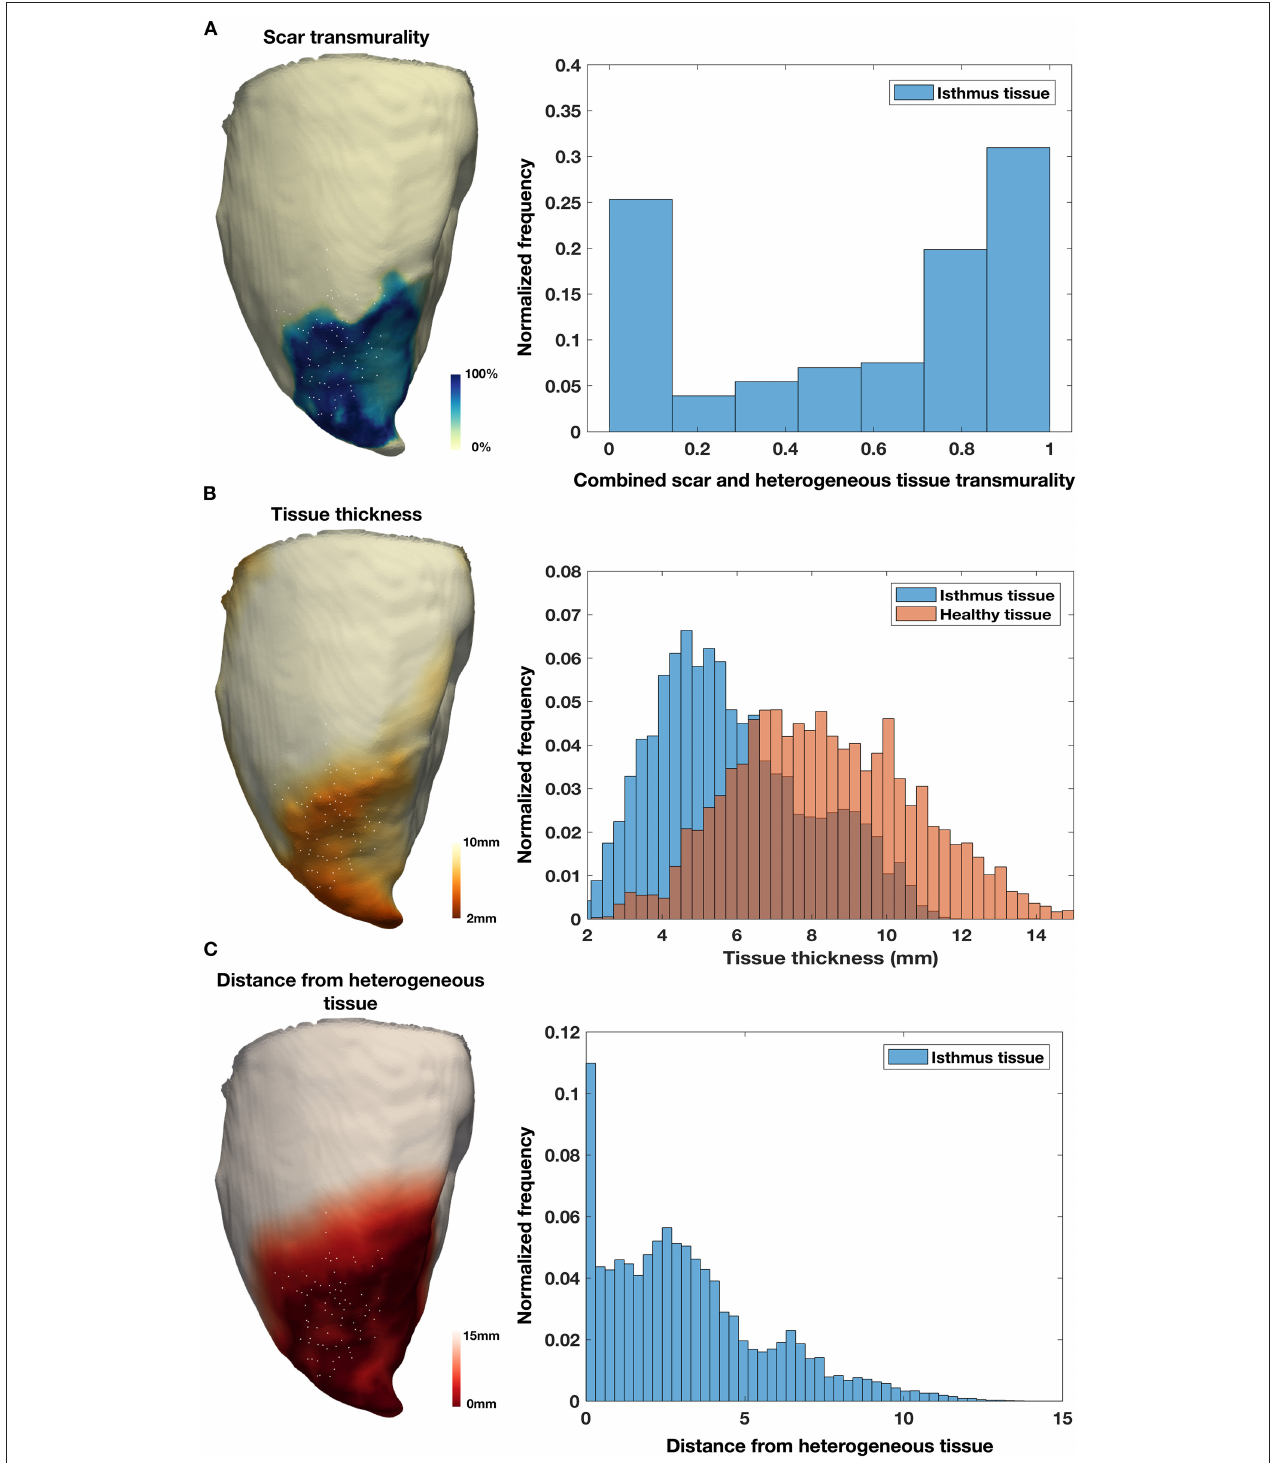
FIGURE 5 | Tissue characteristics of diastolic locations. (A) Example of LGE CMR derived endocardial shell color coded according to scar transmurality and demonstrating antero-septal infarction. Histogram shows combined scar/heterogeneous tissue (HT) transmurality pooled from all locations activated during diastole in all pigs. (B) Example of LGE CMR derived endocardial shell color coded according to tissue thickness. Histogram shows tissue thickness pooled from all diastolic locations (blue) in all pigs compared with tissue thickness at the location of normal EGMs pooled from all pigs (red). (C) Example of LGE CMR derived endocardial shell color coded according to distance from HT. Histogram shows distance from HT pooled from all diastolic locations in six pigs.